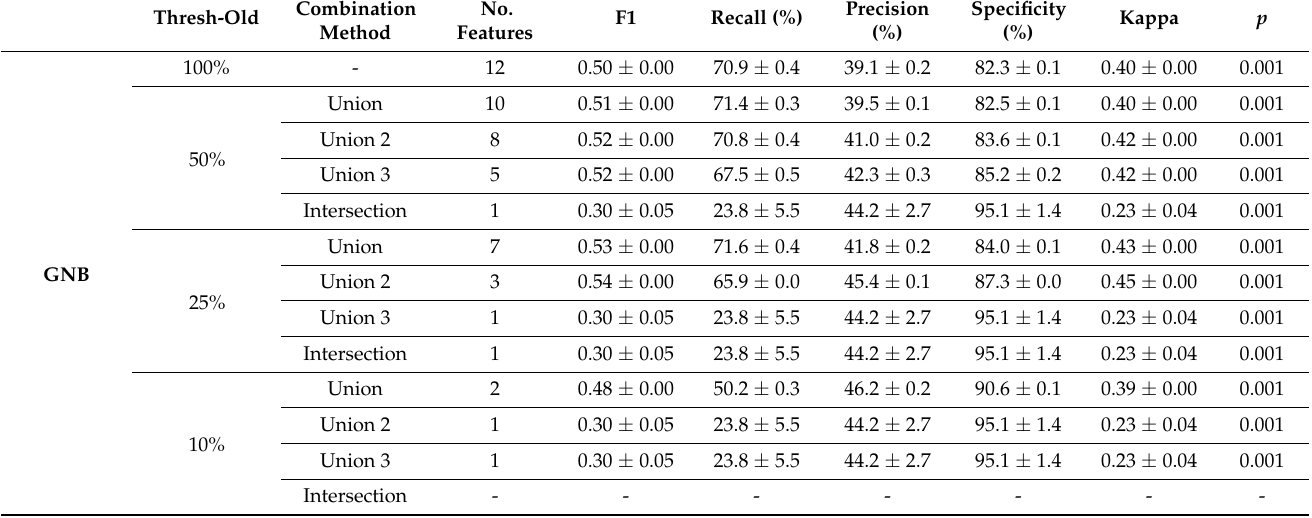
Table A11. Performance of the four classification models on detection fall using Twelve Item